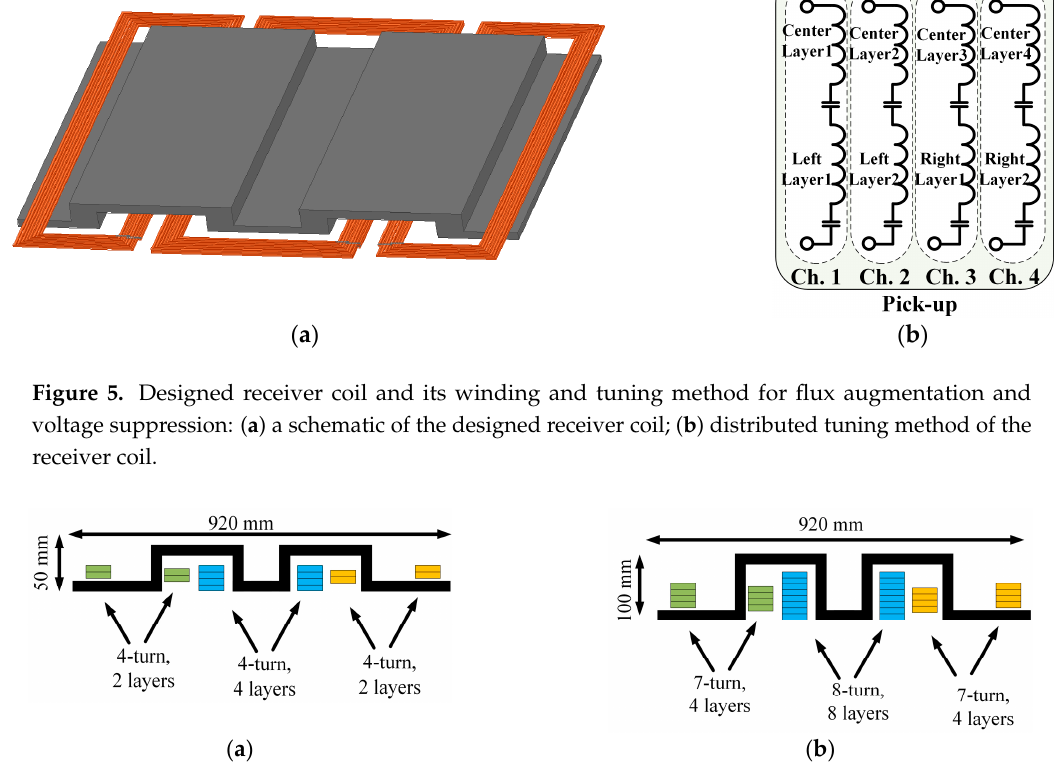
Table 2. Summary of the designed transmitter and pick-up geometries.